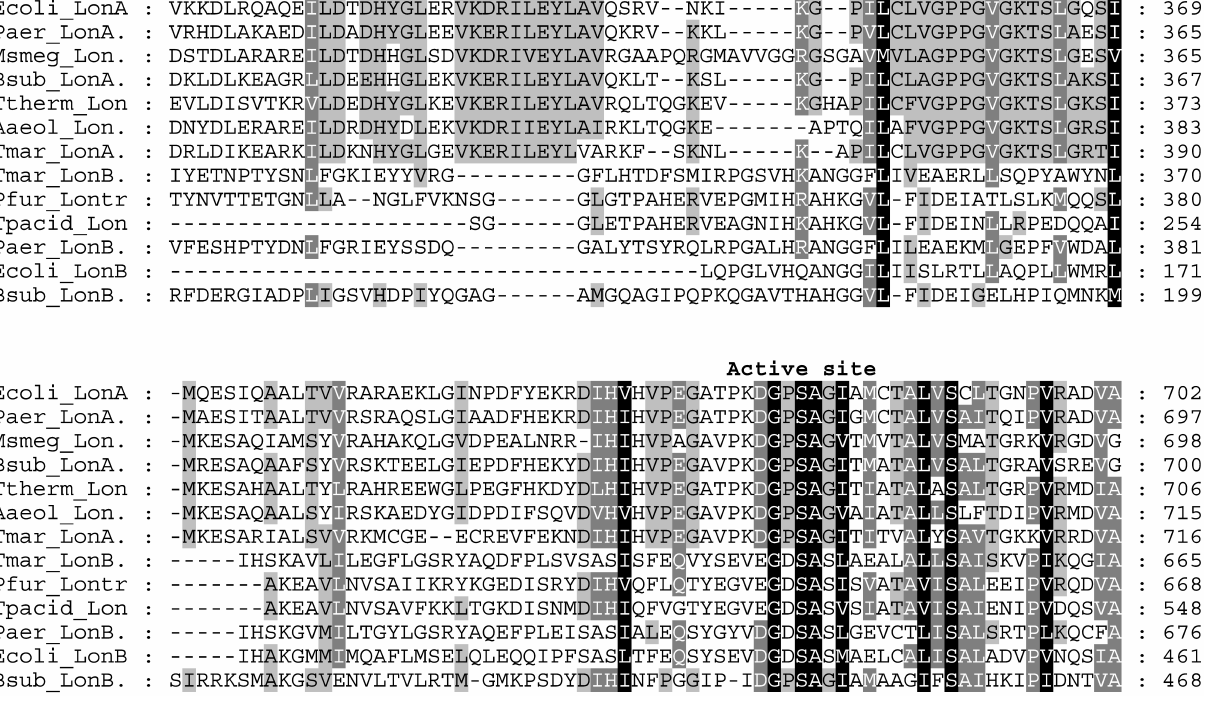
Figure 1. Multiple sequence alignment using CLUSTALX of the ATP-binding domain and active site region of the LonA and LonB homologs. Abbreviations: Ecoli = Escherichia coli ; Paer = Pseudomonas aeruginosa ; Msmeg = Mycobacterium smegmatis ; Bsub = Bacillus subtilis ; Ttherm = Thermus thermophilus ; Aaeol = Aquifex aeolicus ; Tmar = Thermotoga maritima ; Pfur = Pyrococcus furiosus ; and Tpacid = Thermo- plasma acidophilum .